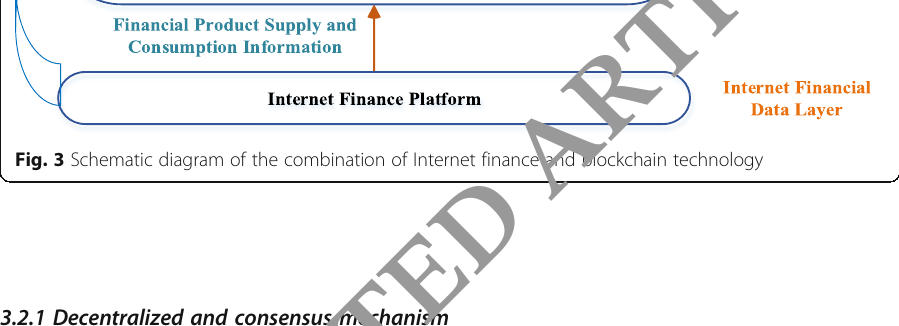
Fig. 3 Schematic diagram of the combination of Internet finance and blockchain